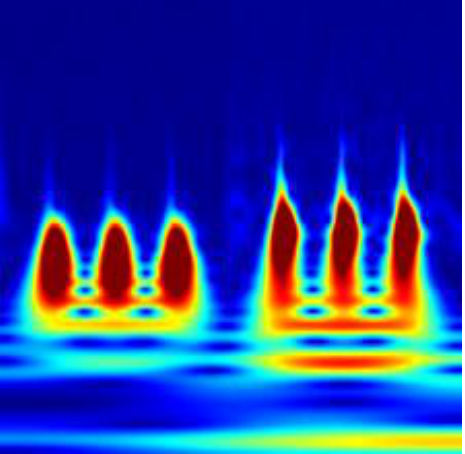
Figure 8. Time-frequency representation for the nominal scenario.